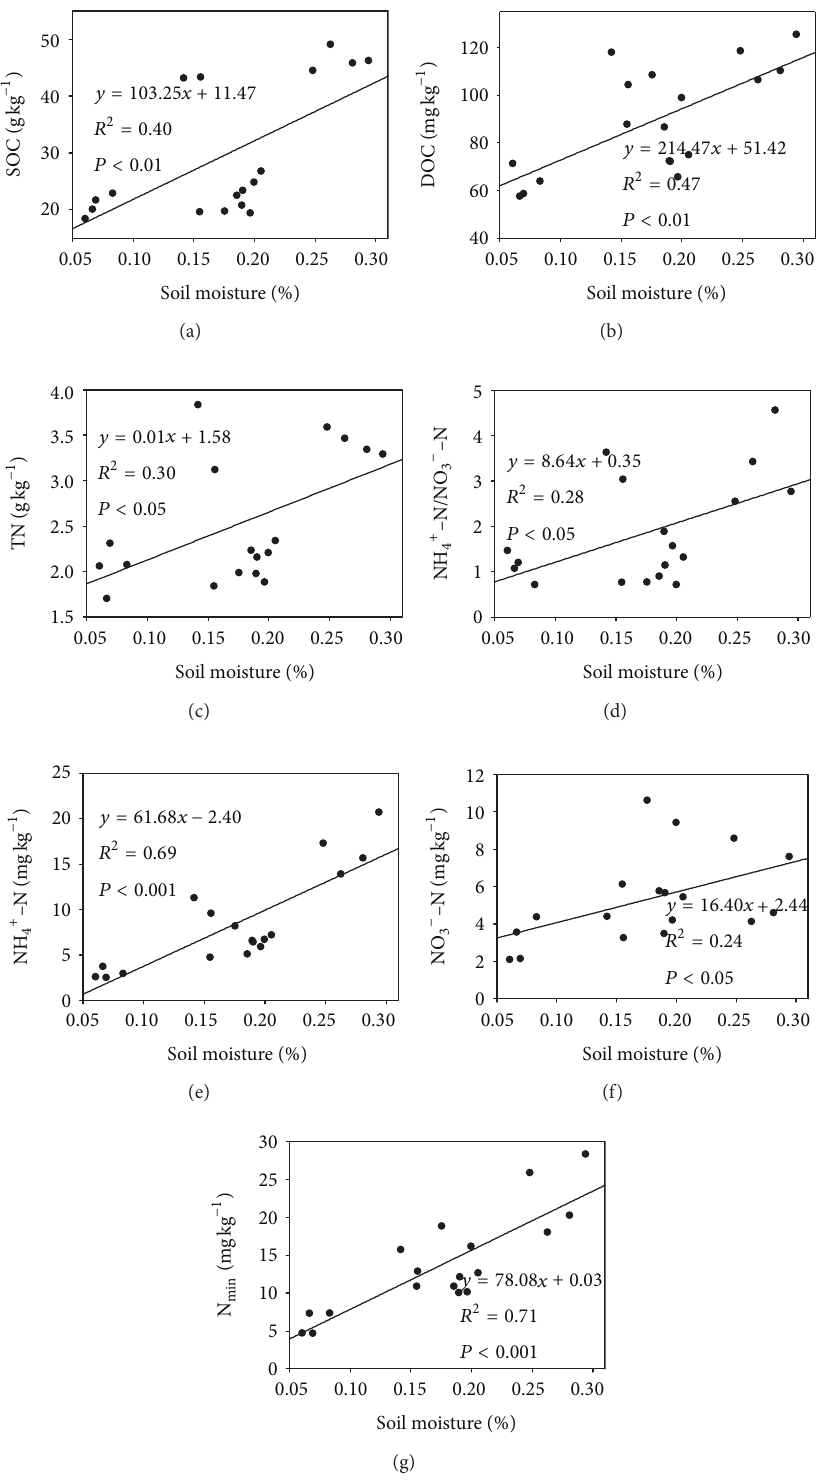
Figure 2: Relationships of soil moisture with soil organic C (SOC), dissolved organic C (DOC), total N (TN), the ratio of NH 4+ -N to NO 3− -N ( NH 4+ -N / NO 3− -N ) , ammonium N ( NH 4+ -N ) , nitrate N ( NO 3− -N ) , and soil inorganic N ( N min )